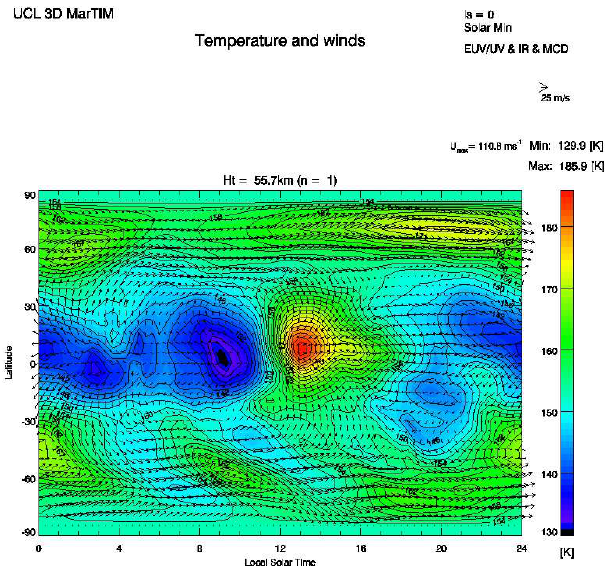
Fig. 10. Pressure level 30 (pressure=2.7 × 10 − 7 Pa) temperature plot for MarTIM+MCD, for solar minimum, L s =0 ◦